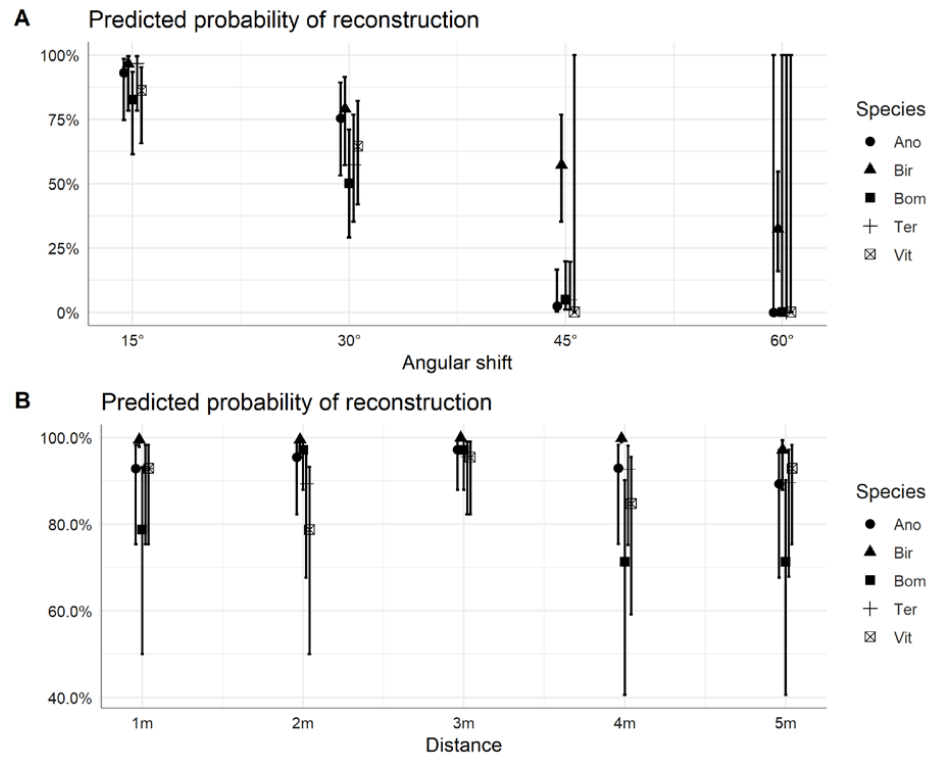
Figure 5. Tri-dimensional model quality in relation to tree species identity and angular shift ( A ), and distance ( B ). Ano: Anogeissus leiocarpa ; Bom: Bombax costatum ; Bir: Sclerocarya birrea ; Ter: Terminalia laxiflora ; Vit: Vitellaria paradoxa.